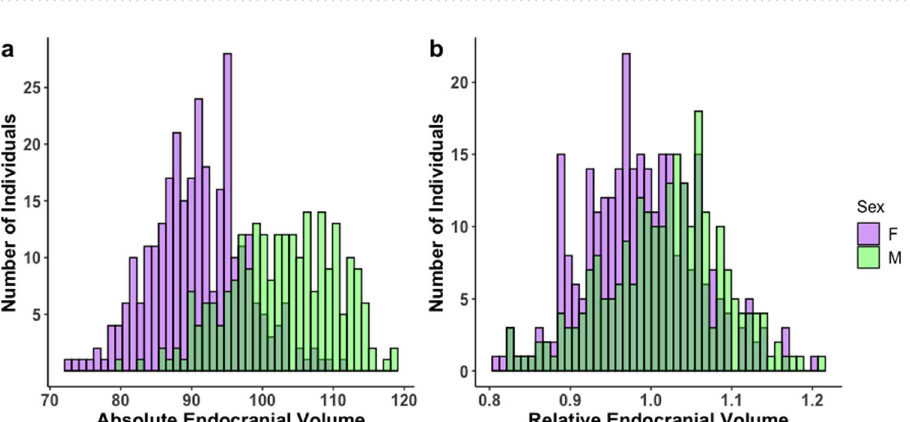
Figure 1. Histogram illustrating variation in absolute endocranial volume ( a ), and relative endocranial volume ( b ) in all specimens included in the study (females = 300, males = 242, total = 542). Relative endocranial volume was calculated as the encephalization quotient (endocranial volume divided by the fitted values of linear model of geometric mean against endocranial volume). Females are depicted in purple and males in green.